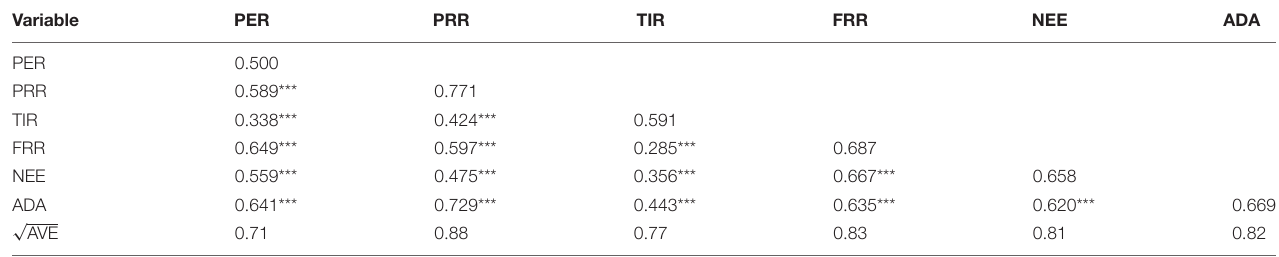
TABLE 5 | Discriminant validity of measurement model. Variable PER PRR TIR FRR NEE